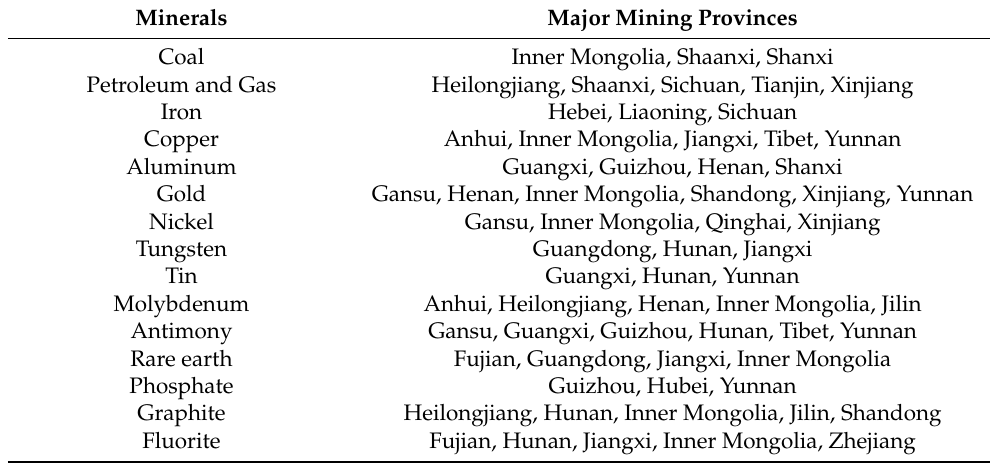
Table 2. Major mining areas by minerals.